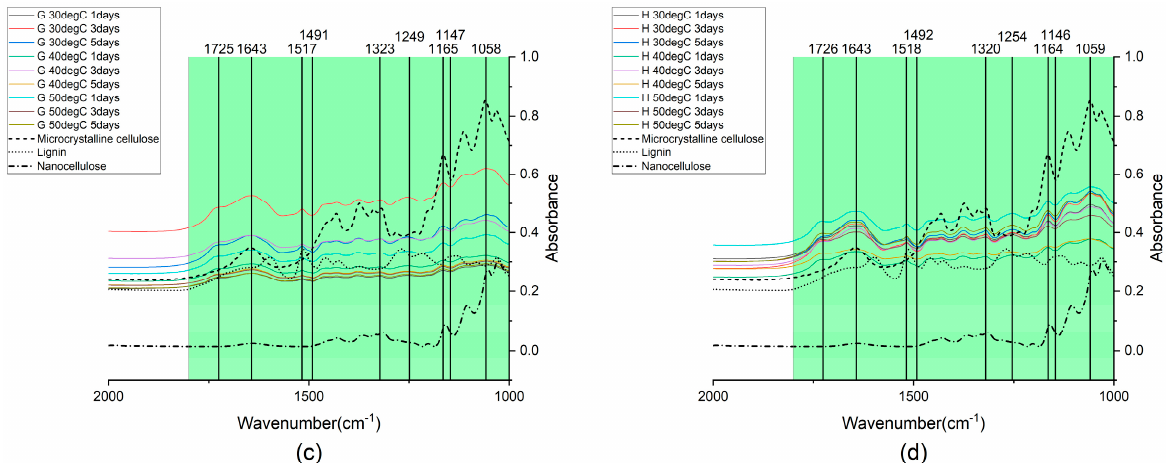
Figure 11. FTIR spectra of leaf samples pretreated at 105 ◦ C at varying incubation temperatures and